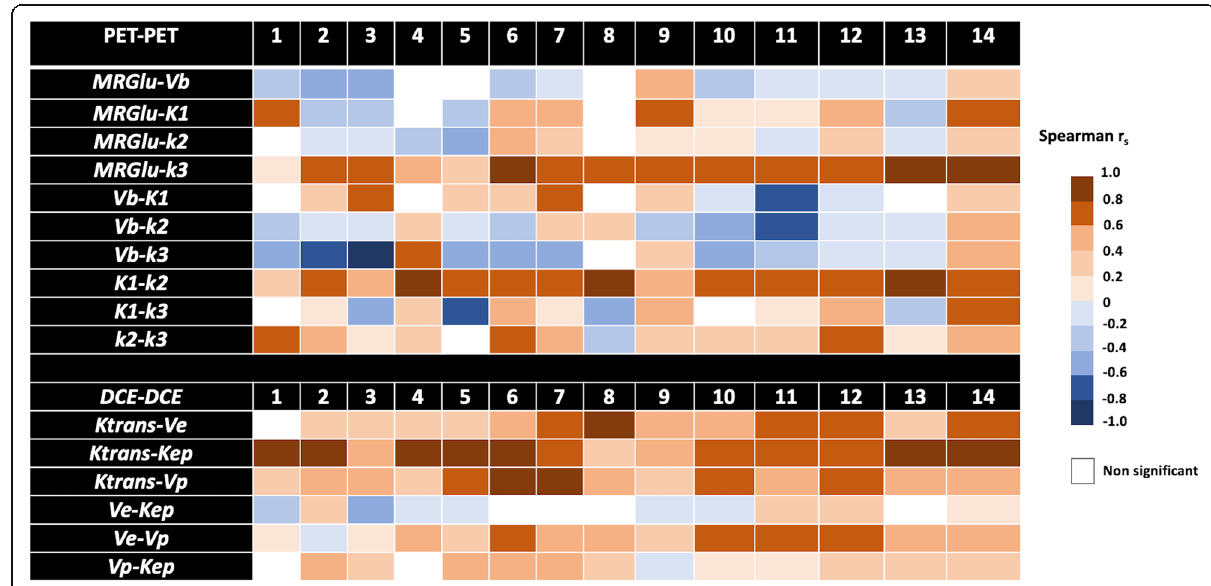
Fig. 4 PET-PET and DCE-DCE Spearman correlation. For each tumor (1 to 14), all the PET-PET and DCE-DCE correlation pairs are provided